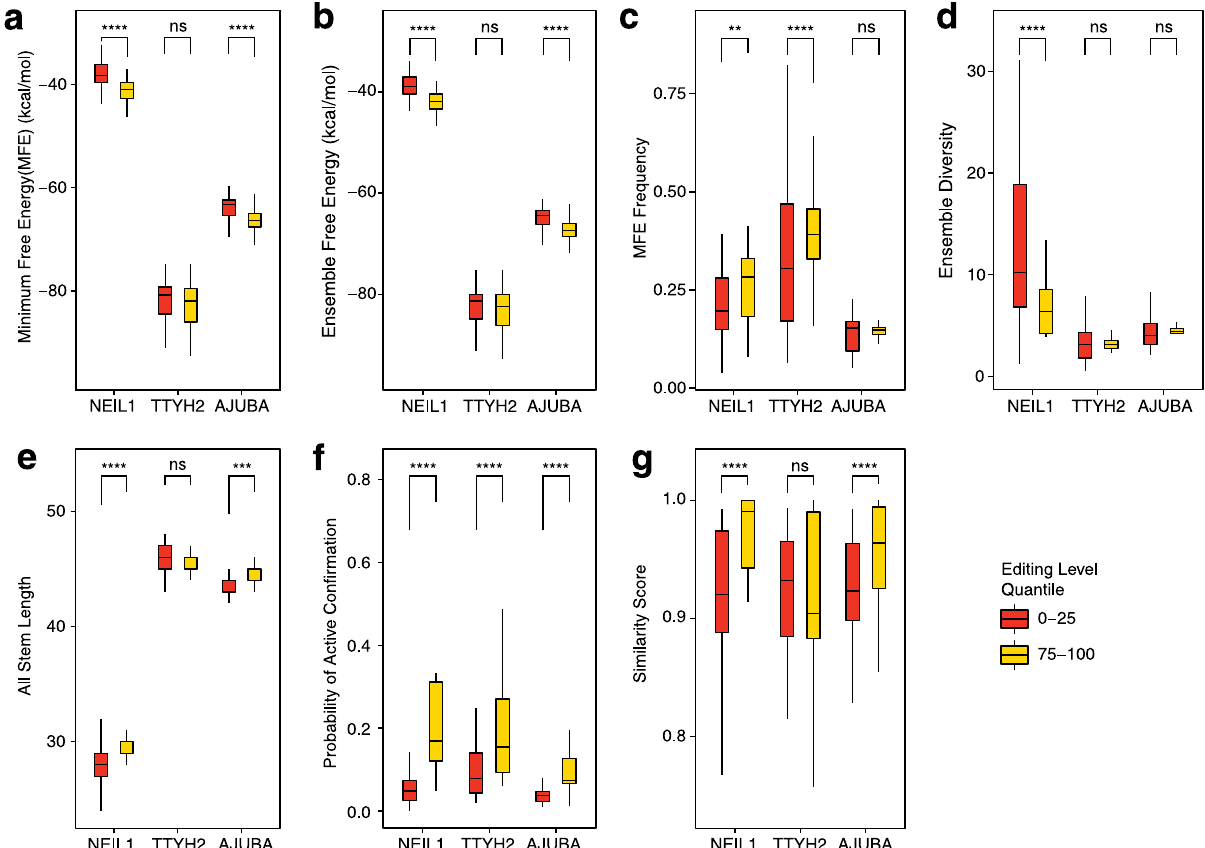
Fig. 5 Cis -regulatory features explain differences of editing levels among RNA variants. a – g Comparing the difference of the highly edited (75 – 100 percentile in editing level in the library, yellow box) with the lowly edited (0 – 25 percentile, red box) variants in each RNA library in terms of thermodynamic and structural features. Two-sided Wilcoxon rank-sum test: ns nonsigni fi cant; ** P < 0.01; *** P < 0.001; **** P < 0.0001, and the exact P values for each feature are: a minimum free energy (MFE), P values: NEIL1 = 4.3e − 12, TTYH2 = 0.44, AJUBA = 9.3e − 07; b ensemble free energy, P values: NEIL1 = 2.2e − 12, TTYH2 = 0.67, AJUBA = 7.2e − 07; c MFE frequency, P values: NEIL1 = 0.0013, TTYH2 = 6.8e − 05, AJUBA = 0.8751; c MFE frequency, P